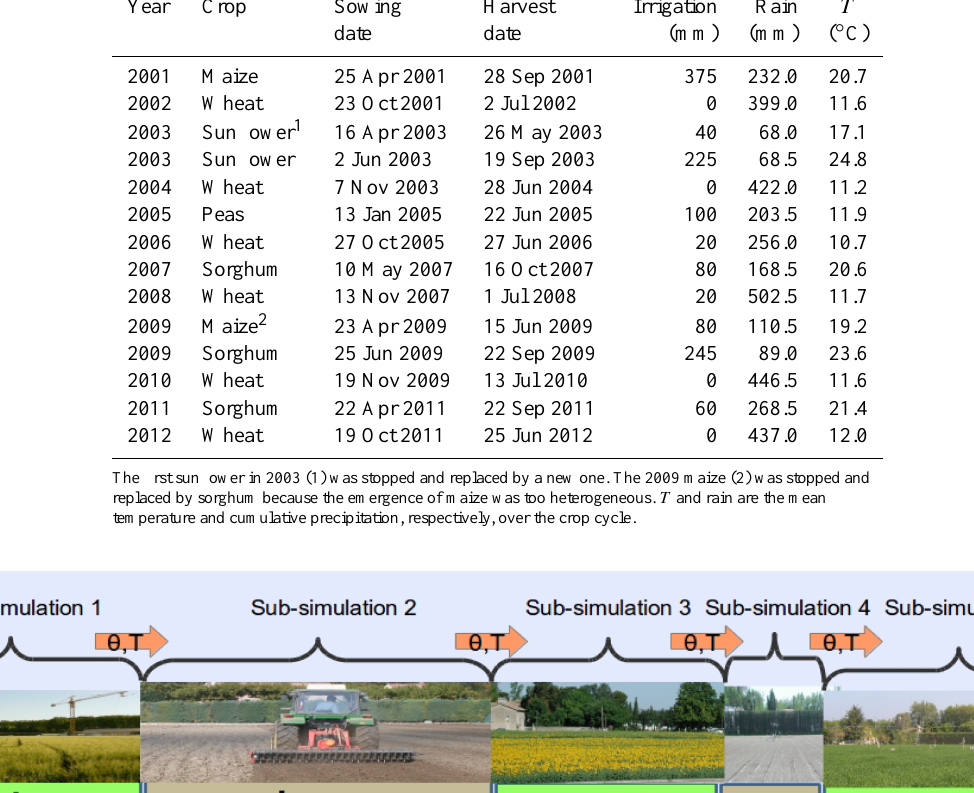
Table 1. 2001–2012 crop succession.